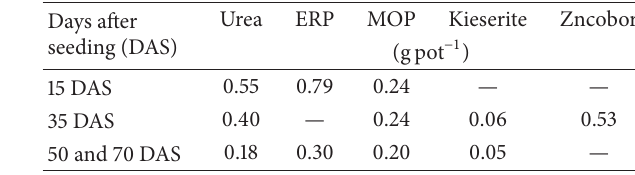
Table 3: Fertilization schedule for the pot